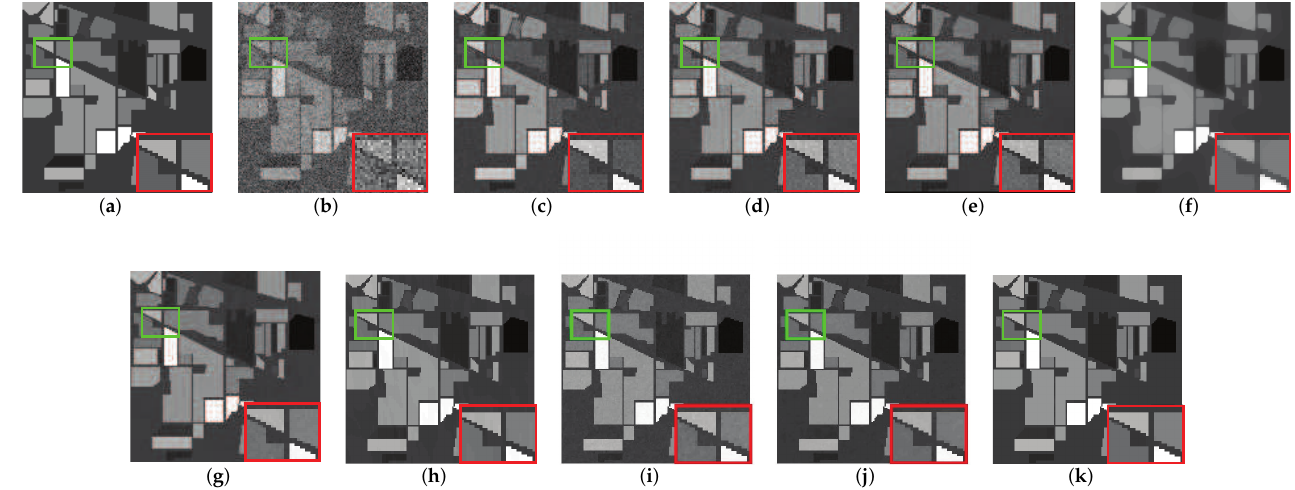
Figure 4. The comparison of the effect of band 200 before and after denoising in the simulated data experiment: ( a ) original image, ( b ) noisy image, ( c ) WNNM, ( d ) LRMR, ( e ) WSNM, ( f ) LRTV,